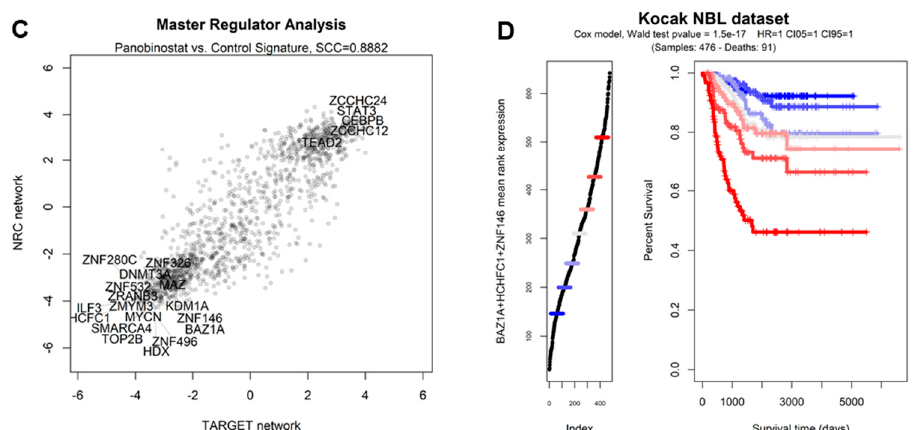
Figure 4. ( A ) Master regulator analysis showing the most significant transcription factors with networks differentially activated in the contrast between PNB-treated Kelly cells and control Kelly cells, graphically depicted as in [20]. In brief, the leftmost column indicates the p -value of the observed pattern; the central barcode-like graph indicates the distribution of activated (red bars) and repressed (blue bars) targets of a TF, in positions ranked according to the PNB vs. control signature (leftmost: most downregulated by PNB, rightmost: most upregulated by PNB). The “Act” and “Exp” columns report the normalized enrichment score (NES) as the predicted activity of the whole TF network and the expression level of the TF itself. The number to the right indicates the ranking of the TF in terms of the significance of the transcriptome-wide differential expression analysis. Analysis and plotting were performed with the viper R package [35]. The overall network in this panel was derived from the NBL NRC cohort (obtained from [20]). ( B ) Master regulator analysis as in the previous panel with network derived from the TARGET cohort (also obtained from [20]). ( C ) Comparison of master regulator analyses based on the PNB-treated vs. control contrast using two complementary NBL-based networks: TARGET (x-axis) and NRC (y-axis). Candidate MRs with the highest absolute combined NESs are shown as labels. ( D ) Kaplan–Meier curve indicating the association between BAZ1A expression and survival in the Kocak NBL dataset [48]. Patients are divided into groups of increasing BAZ1A expression (left) and shown with regard to survival time vs. percent survival (right). p -value calculated with the Wald test [20].